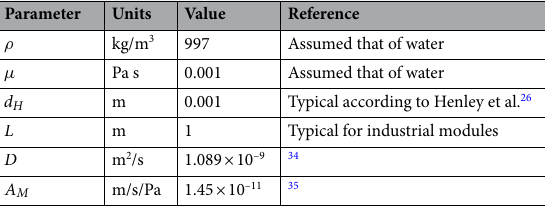
Table 3. Assumptions, used to estimate the flux in the RO